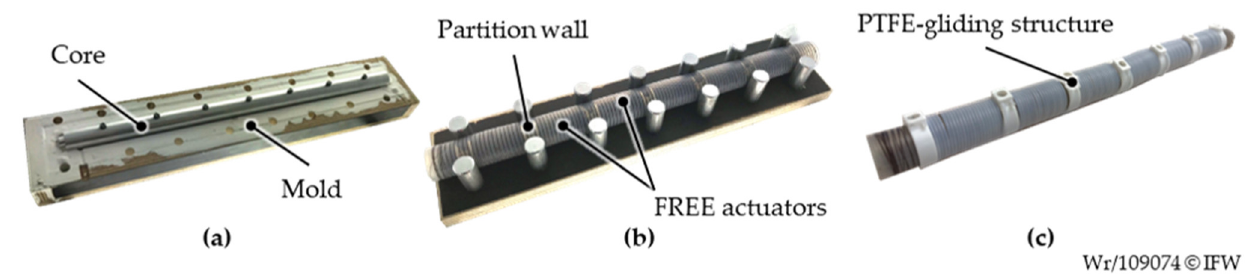
Figure 9. ( a ) Mold half and core for inner silicone hull; ( b ) frame for gluing the partition walls; ( c ) consolidation element with assembled gliding structure.